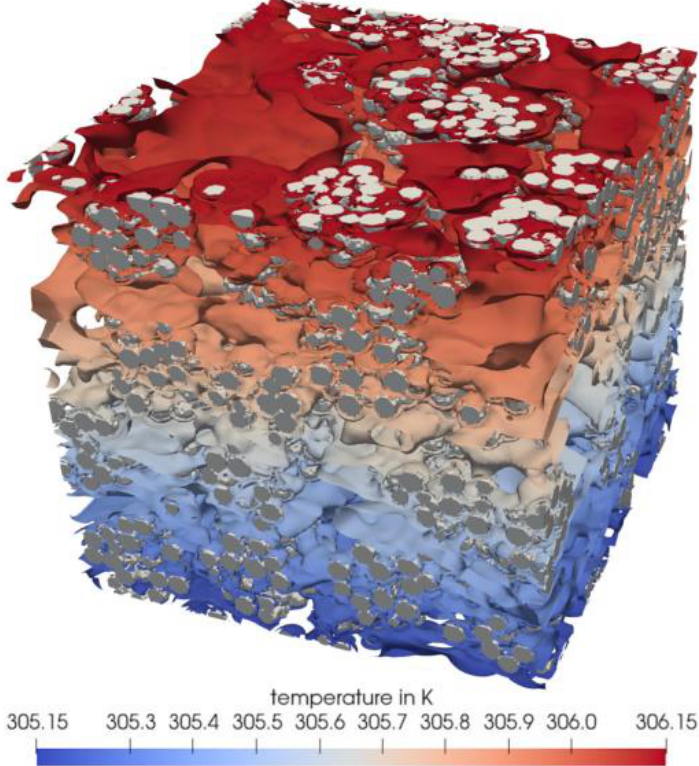
Figure 19. Temperature distribution simulated through three-dimensional packing of silica parti- cles.